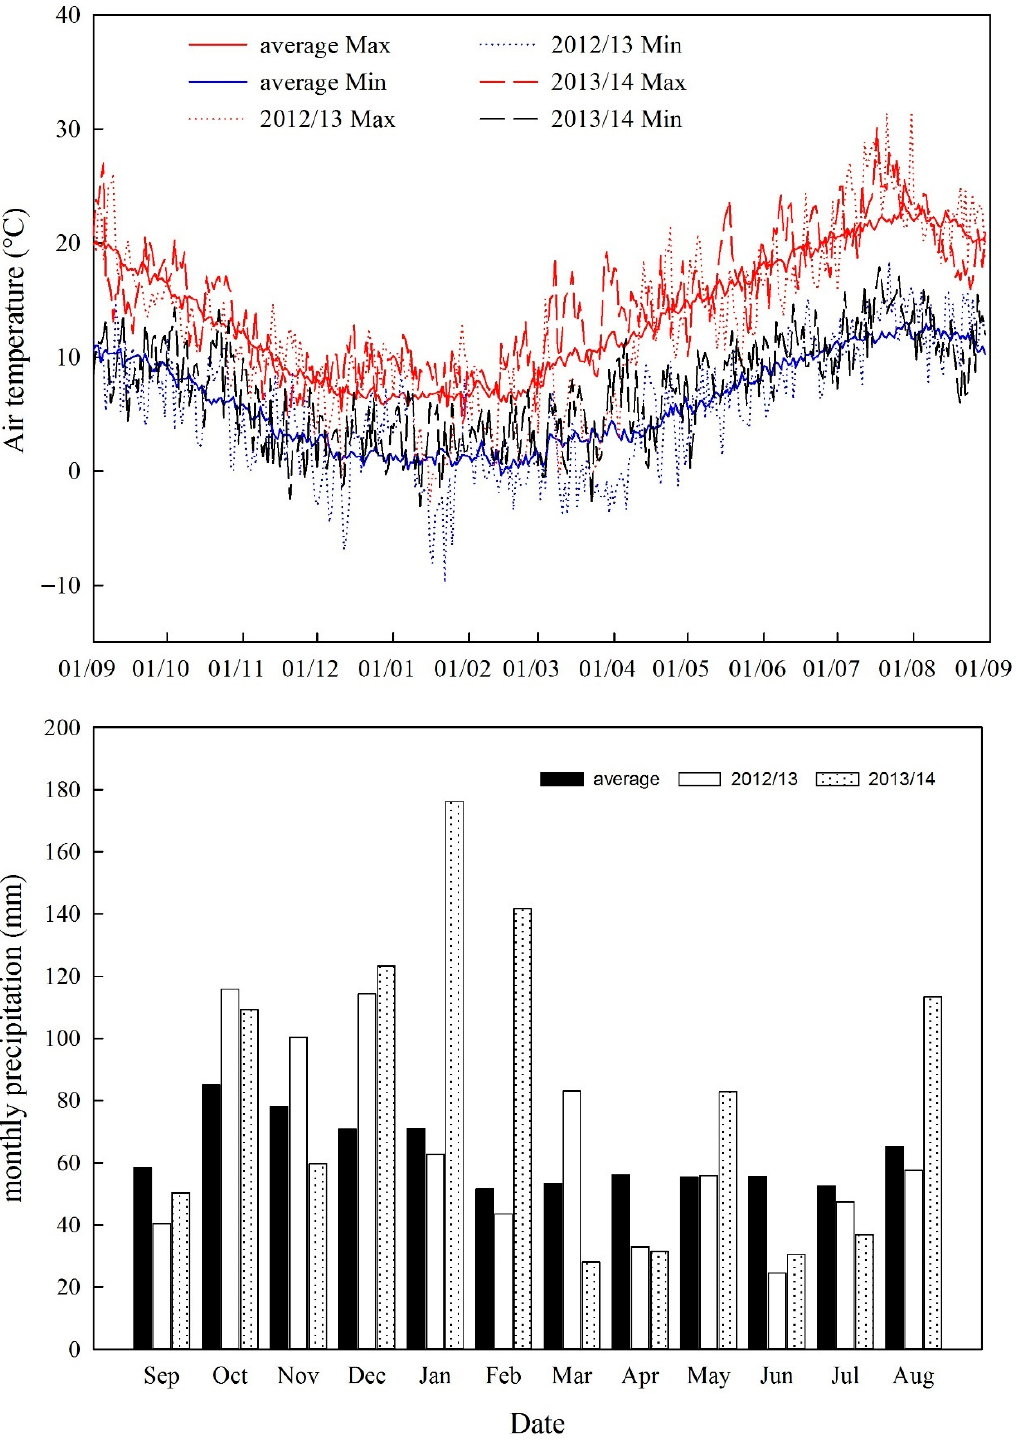
Figure 6. Dynamics of daily maximum and minimum air temperatures and monthly precipitation during the growing seasons (October–July) and historic averages between 1981 and 2010. Table 3. General characteristics of the 0–23 cm soils of the six plots sampled of the Exhaustion Land Experiment.